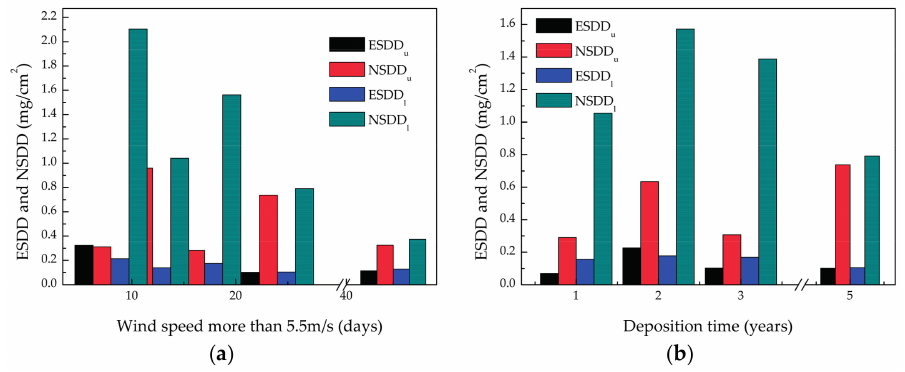
Figure 12. Effects of influencing factors on ESDD and NSDD. ( a ) Wind speed ≥ 5.5 m/s · days; ( b ) Deposition time.